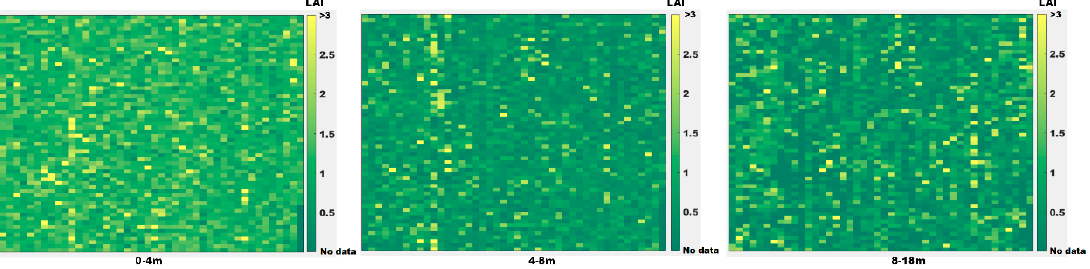
Figure 14. The contribution ratio of different height level LAI (i.e., LAI integration from 0–4 m, 4–8 m, 8–18 m) to the total LAI (LAI = 4 ± 0.1). GLAS LAI vs. MODIS LAI The GLAS and MODIS LAIs were found to correlate poorly (Figure 15). The overall correlation coefficient was only sqrt (0.003), although the comparison of the two gave relatively low RMSE (1.69) and bias (0.89). The differences between the GLAS and MODIS LAI values were highly skewed because of large positive differences at low and middle LAIs [Figure 15b]. The main reason for the poor correlation was likely attributed to the differing characteristics of the two LAI products. In particular, the MODIS LAI retrieval algorithm accounted for vegetation clumping through 3-D radiative transfer modeling [55,56] and was supposed to provide the true LAI. In contrast, our GLAS method did not consider the clumping effect and derives only the effective LAI. Therefore, the MODIS LAI tended to be higher than the GLAS LAI. Interestingly, for the LAIs higher than 4, the pattern was reversed with higher values for GLAS [Figure 15a]. This reversal was due to the saturation of MODIS LAI at approximately 5.5 [Figure 15a]. However, the GLAS LAI estimates showed no signs of saturation, even up to 8 [Figure 15a]. Overall, the comparison clearly highlighted the unique value or even potential superiority of lidar data for measuring LAI for dense forests—an expected finding consistent with the majority of lidar studies over forests of medium to high biomass [57].